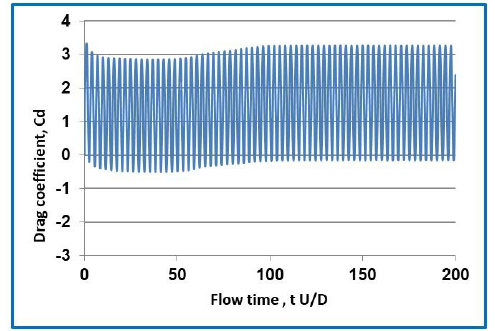
Figure 13: Phase portrait at f v = 0.5 f s , crossflow vibration